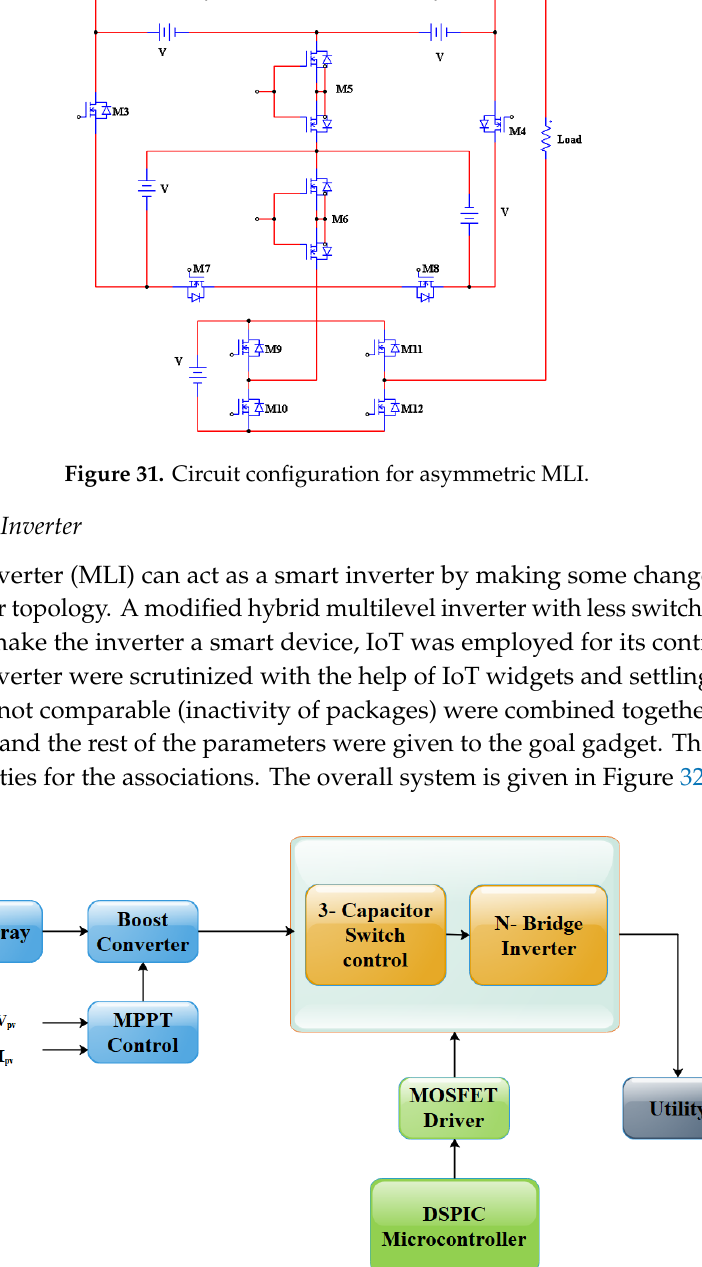
Figure 33. Circuit diagram for nine-level Inverter. To maintain a high voltage profile, an intelligent control technique can be used to control the operations of the multilevel inverter. Another topology of MLI was discussed in [42]. In this paper, the authors have implemented a circuit by integrating a full bridge inverter and combination of switched DC sources [43]. The generalized circuit diagram of the above-mentioned hybrid MLI is shown in Figure 34.